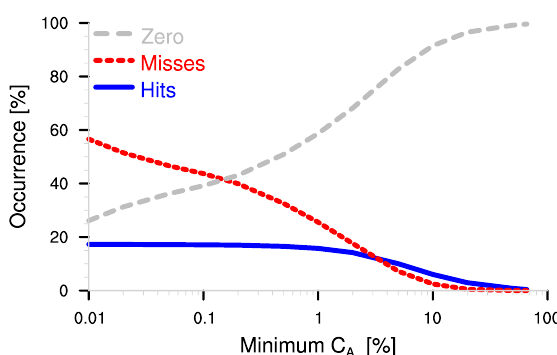
Figure 2. The frequency of occurrence (%) of hits ( R T > 0 and R A > 0; blue solid line), misses ( R T = 0 and R A > 0; red dotted line), and zero rain cases ( R T = 0 and R A = 0; gray dashed line) for the S-Pol data as a function of the minimum area rain coverage C A (%). The sum of hits, misses, and zero rain always adds up to 100%, as in Table